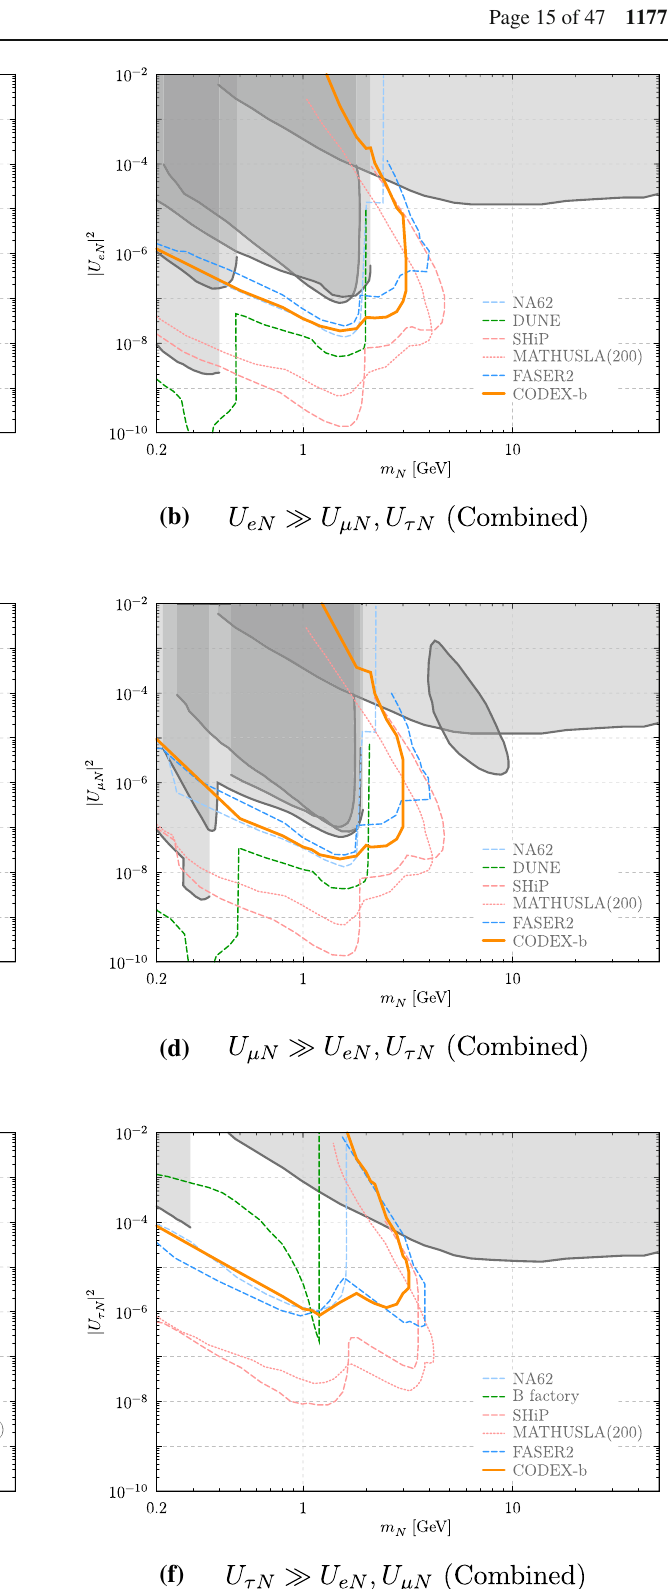
Fig. 14 Projected sensitivity of CODEX-b to Dirac heavy neutral lep- tons. Left: Contributions from the individual decay channels with the net result (orange). Right: Comparison with current constraints (gray) and other proposed experiments, including NA62 [101], DUNE [102], SHiP [17], FASER2 [103], and MATHUSLA [83], which is shown